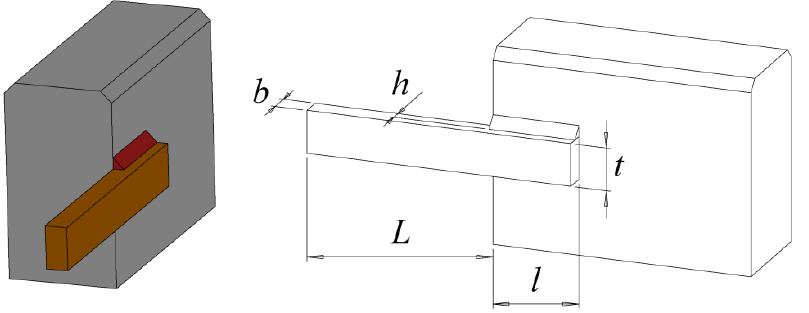
Figure 11. The welded beam design problem is the 3D model diagram ( left ) and structural parameters ( right ).